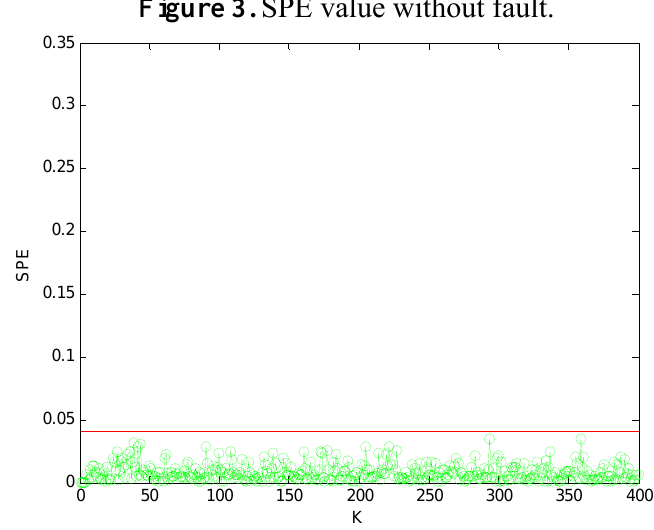
Figure 3. SPE value without